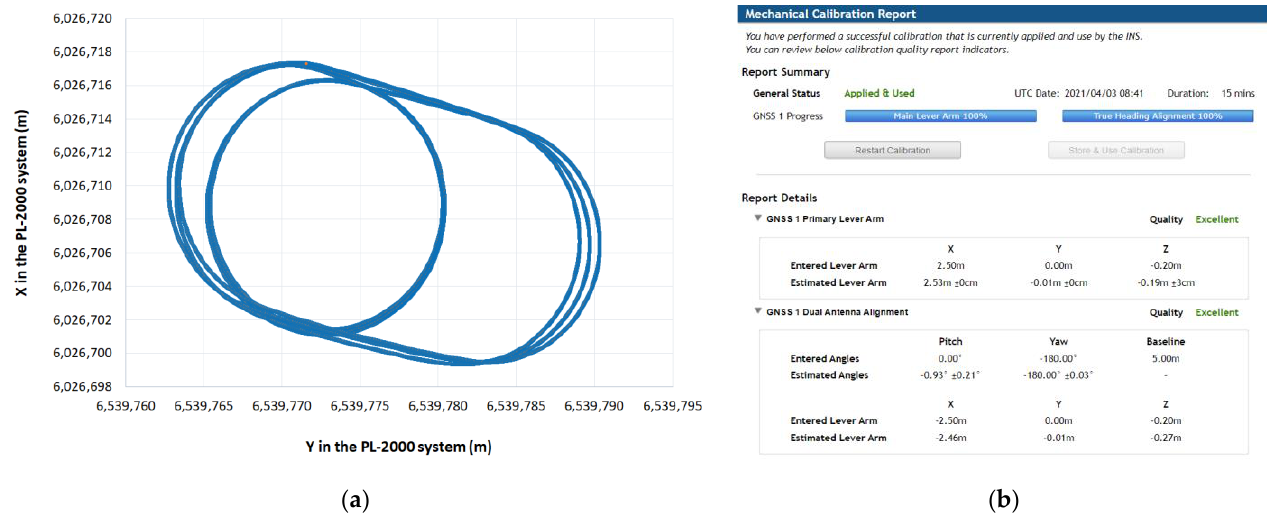
Figure 4. Melex movement trajectory ( a ) and the results of the Ekinox2-U system calibration ( b ) of 19 May 2021.